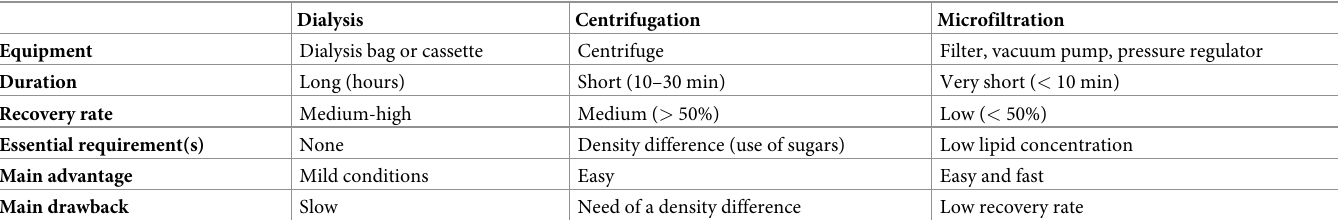
Table 2. Comparison of GV purification